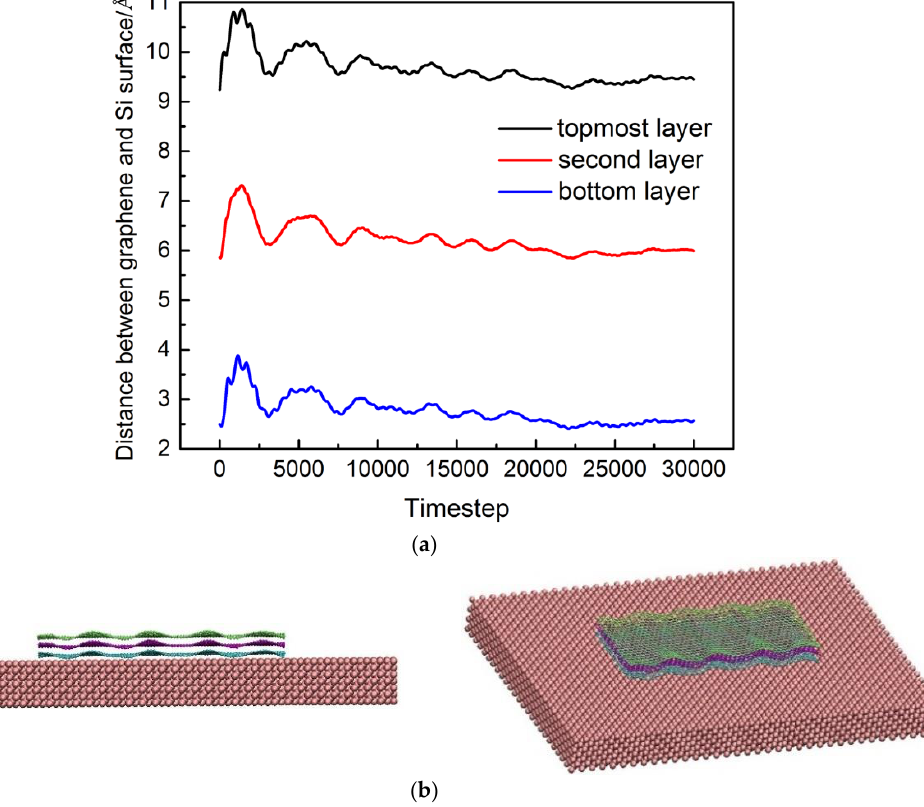
Figure 2. Adhesion behavior in a three-layer graphene system, where the vertical upward velocity is 5 Å /ps: ( a ) The variation of distance between graphene and the Si substrate surface with timestep; ( b ) atomic trajectory of the three-layer graphene system.